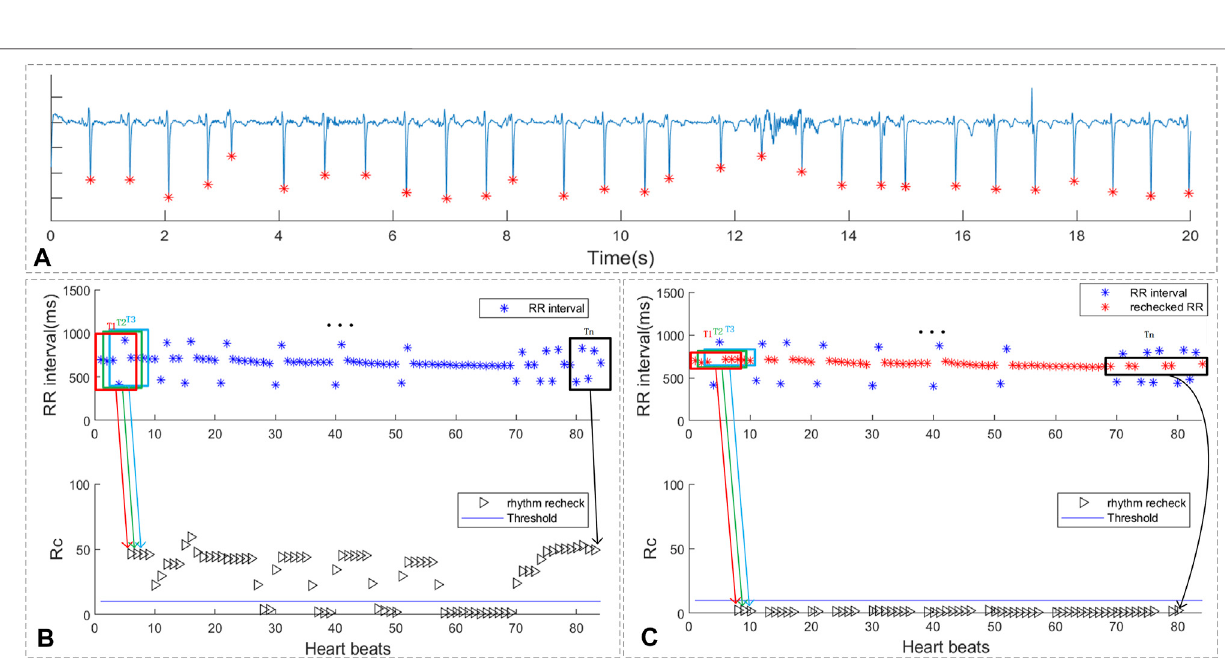
Frontiers in Physiology |